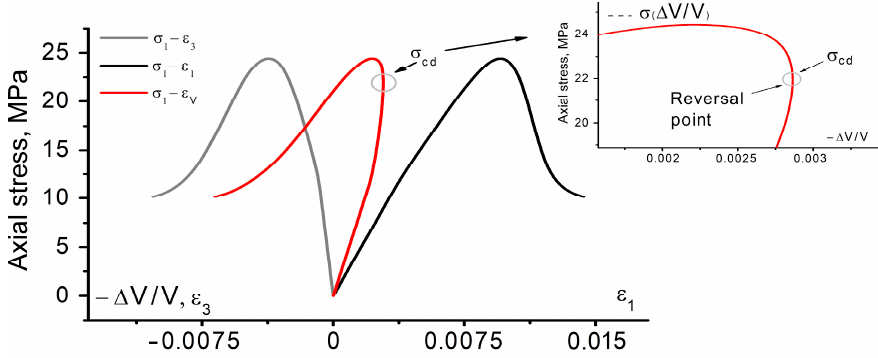
Figure 9. Complete stress-strain curve obtained by numerical modeling.